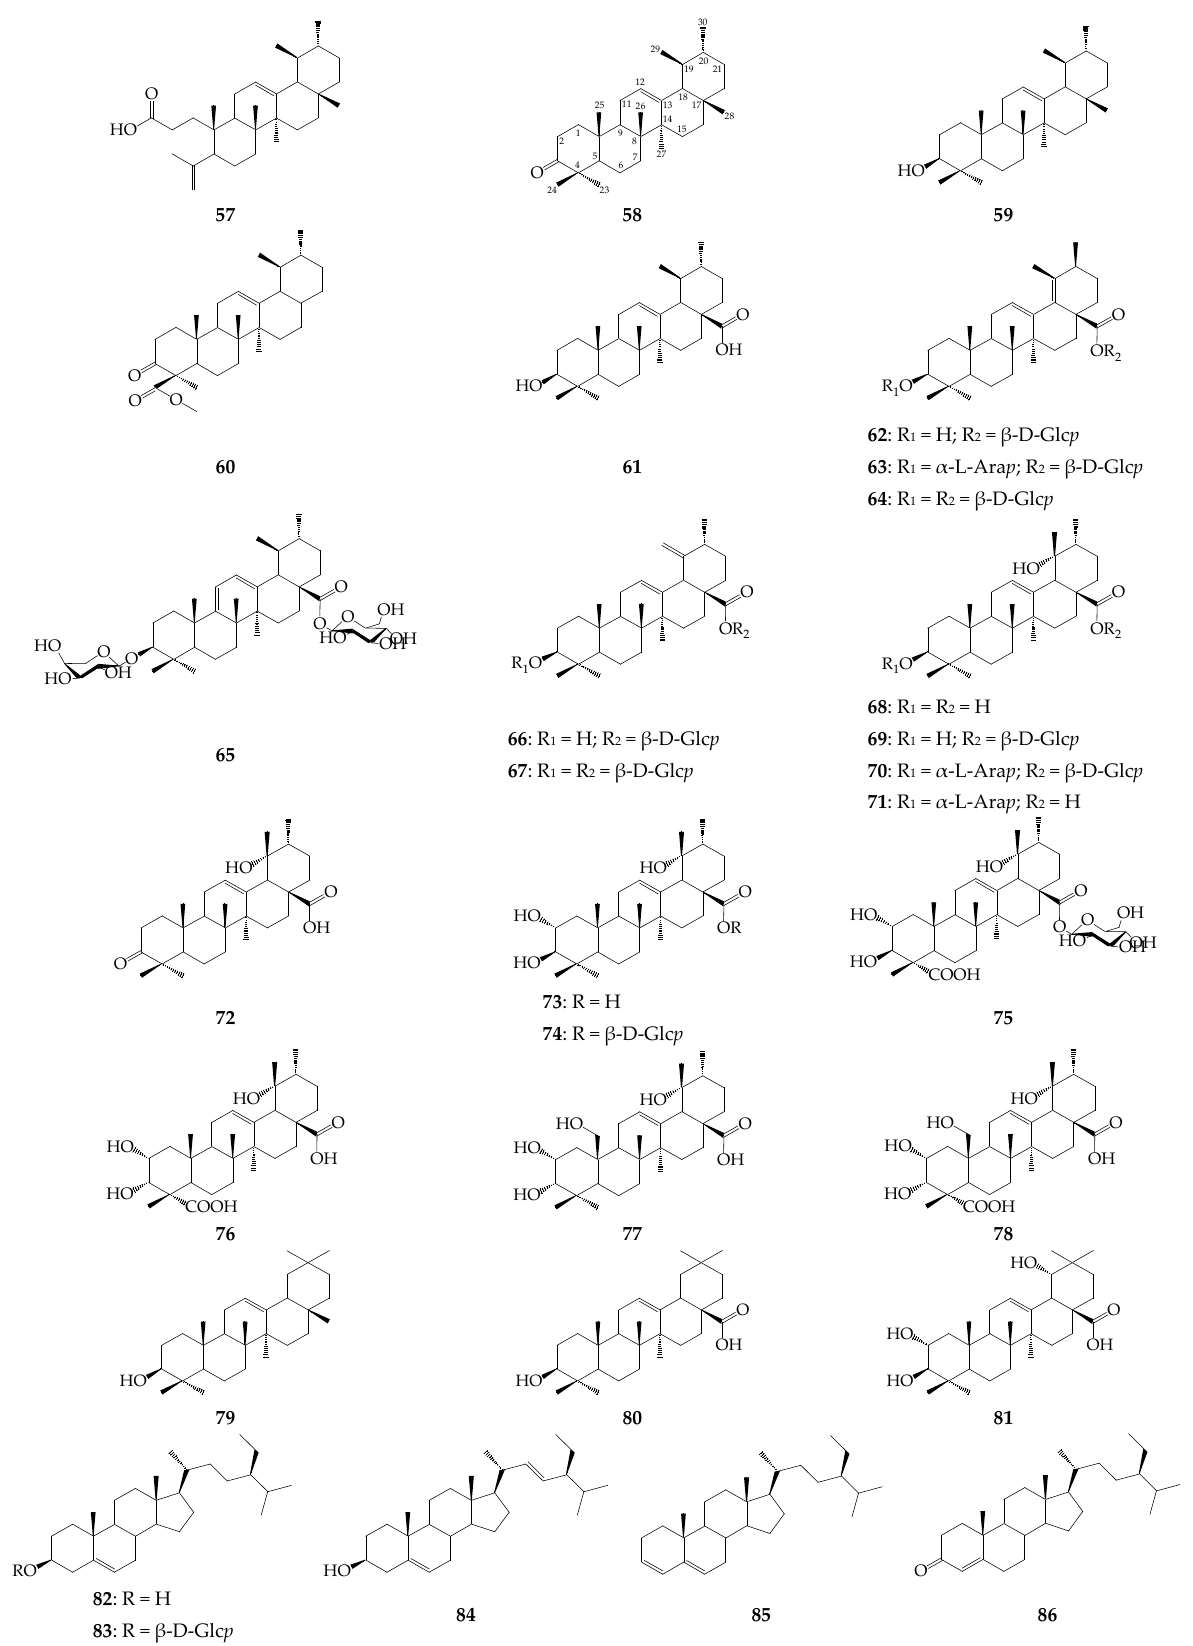
Figure 4 . Triterpenes 57 – 86 . Α -L-Ara p – α -L- arabinopyranose; β -D-Glc p – β -D-glucopyranose. Figure 4. Triterpenes 57 – 86 . A-L-Ara p – α -L-arabinopyranose; β -D-Glc p – β